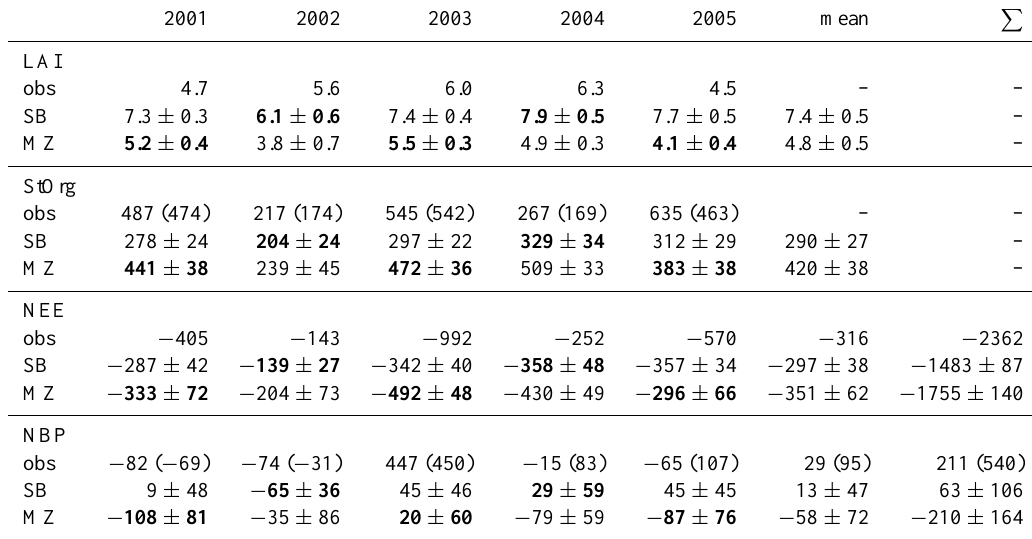
Table 1. Observed (at Bondville) and study area model averages and standard deviations for maximum LAI (m 2 m − 2 ), storage organ C at maturity (StOrg (gCm − 2 )), and all-year cumulative NEE and NBP (gCm − 2 yr − 1 ). Observed storage organ C is shown for field dry matter samples, and farmer reported values (in parentheses). Bold model values are same crop types as at Bondville. Model values (experiment DAmod) are averages of all soybean (SB) or maize (MZ) field patches in a given year. Data are only shown for years when Bondville dry matter data are available for comparison